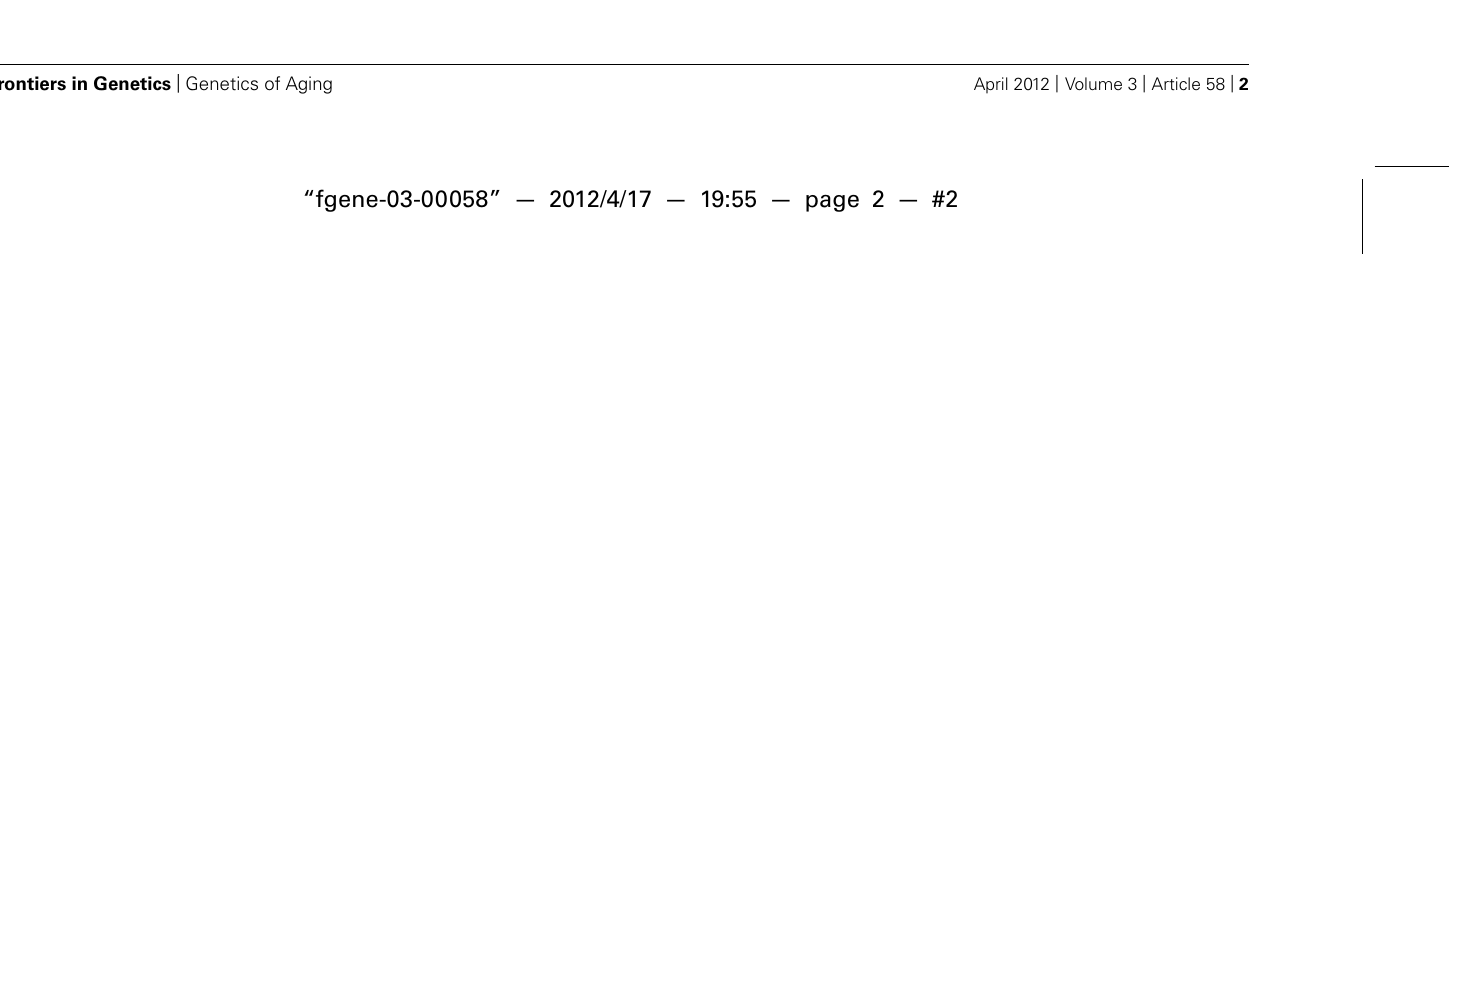
FIGURE 1 | Flow of all participants through the Phase 1 CALERIE trial in Baton Rouge and the subset of subjects with inflammatory assessments. Note the fourth group (low-calorie group highlighted in gray) was excluded from the inflammatory marker